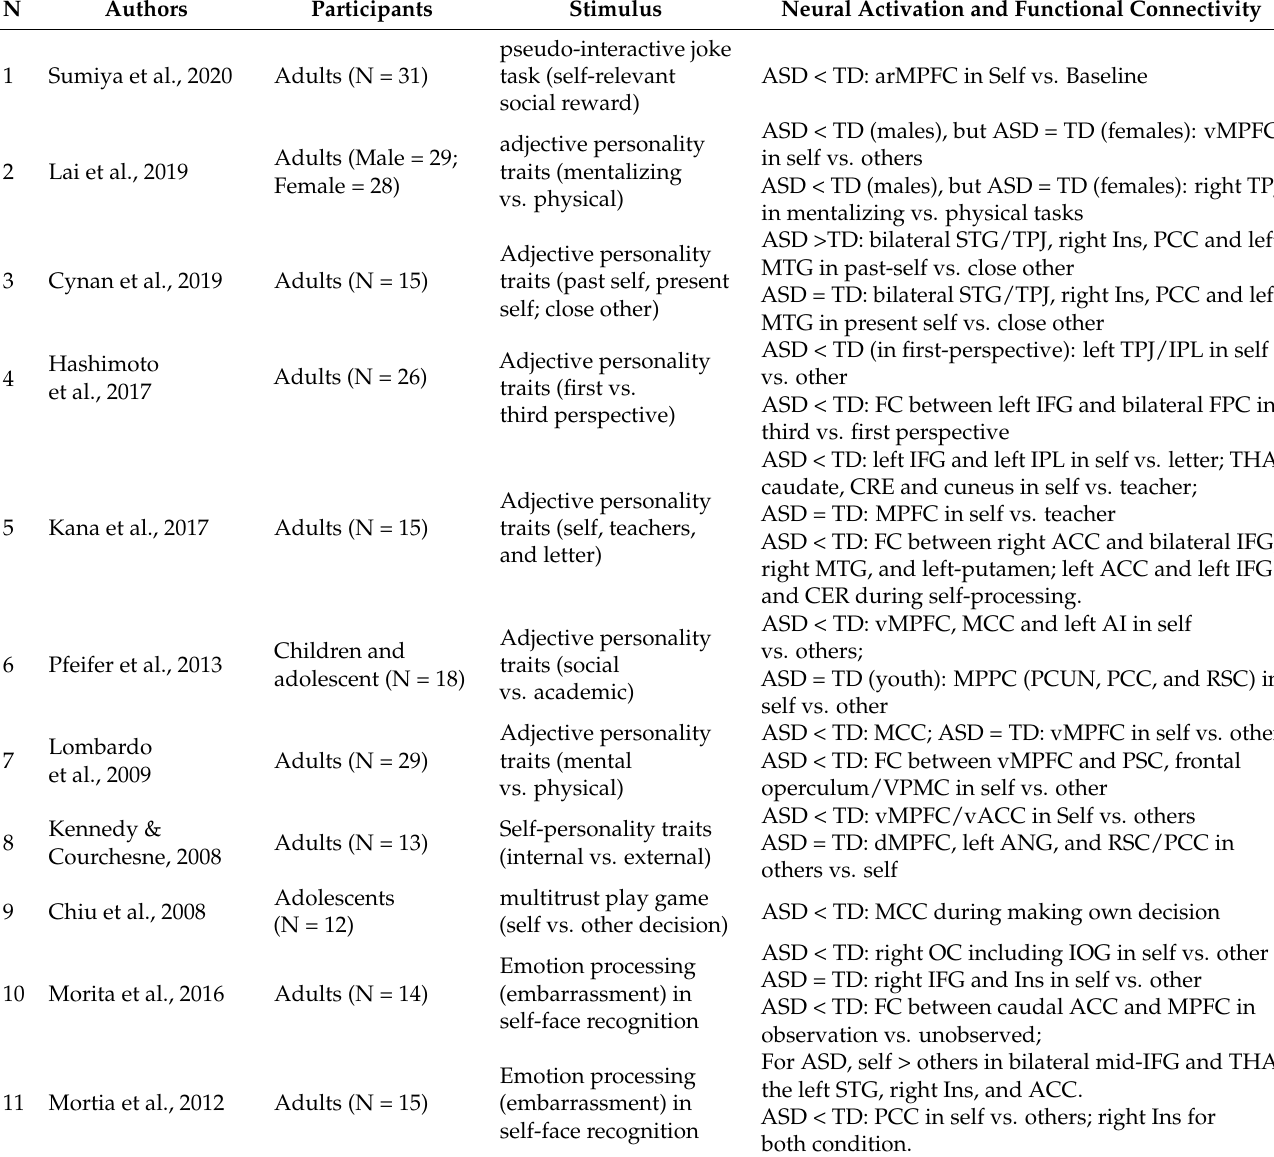
Table 1. Characteristics and main findings of fMRI studies with self-relative tasks in individuals with